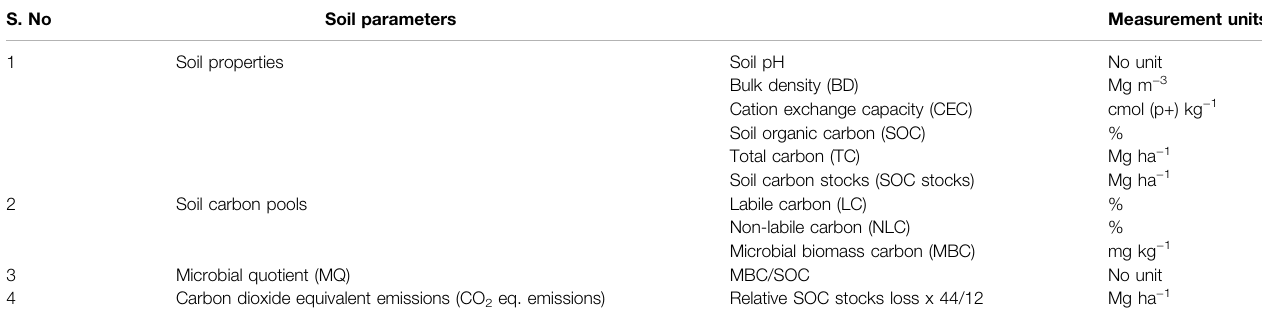
TABLE 2 | Soil parameters considered in the study.